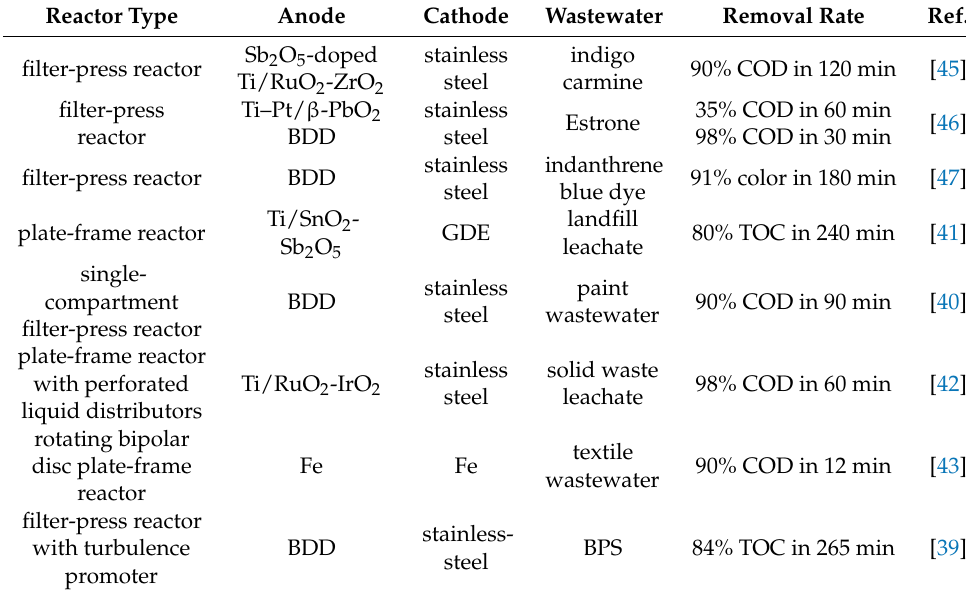
Table 1. The treatment of different organic wastewater using plate-frame